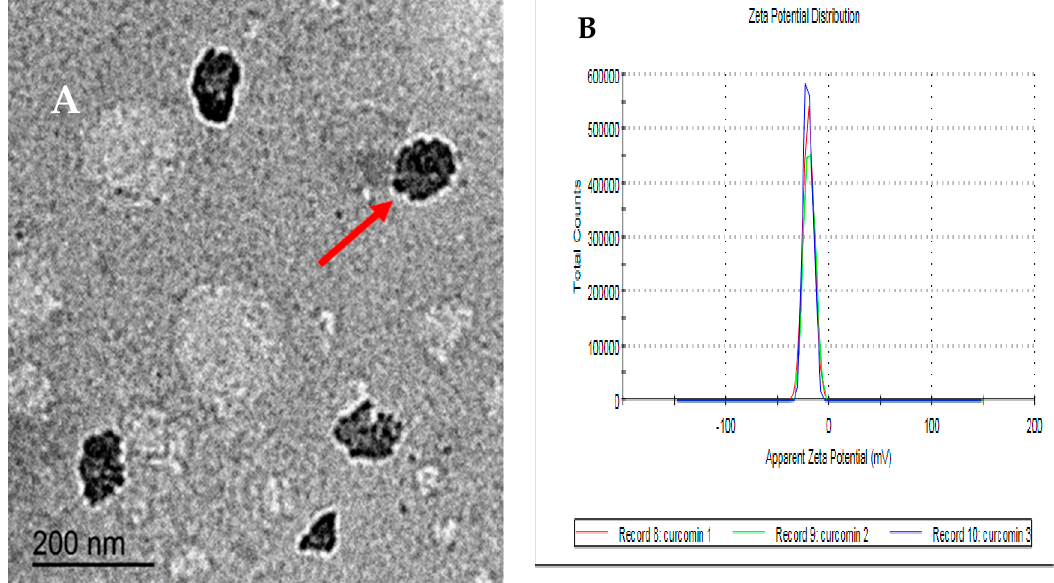
Figure 1. A transmission electron microscopic (TEM) image showing a nearly spherical shape of curcumin nanoparticles (CUNPs) with a smooth surface and uniform size distribution ( A ) and histogram showing the apparent zeta potential (mV) of CUNPs ( B